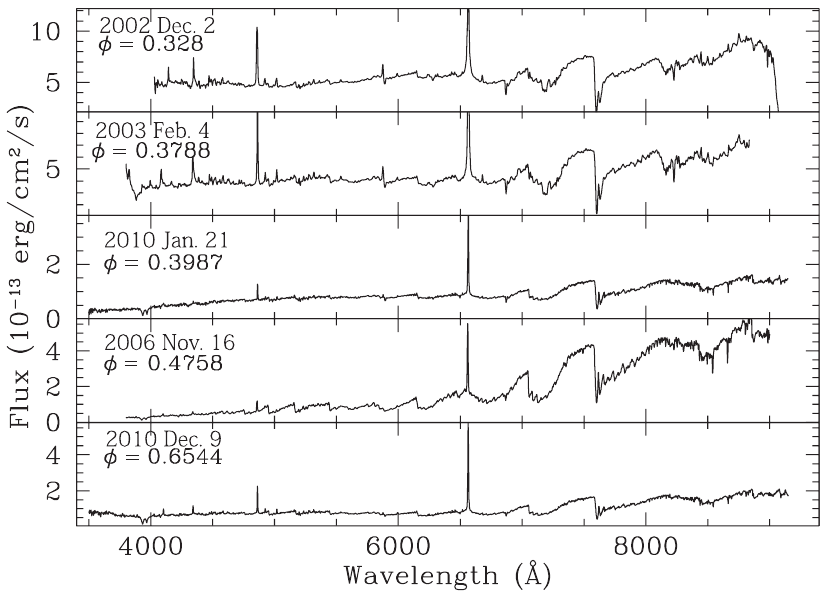
Fig. 3. The spectra of BX Mon during phases 0.3{0.7.